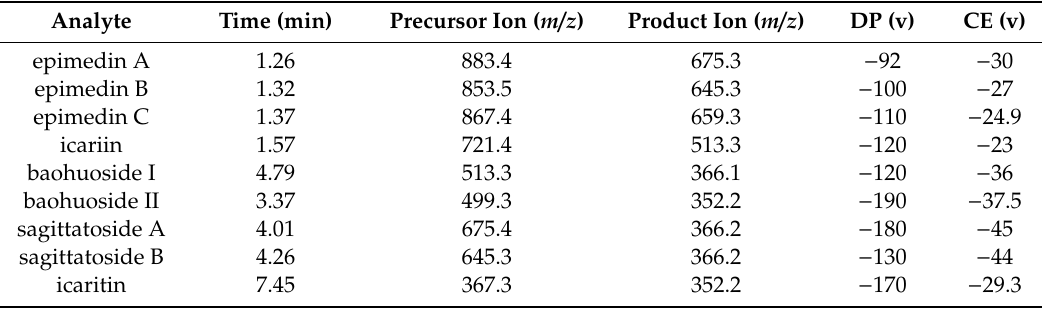
Table 2. Multiple reaction monitoring conditions of nine analytes in negative ionization